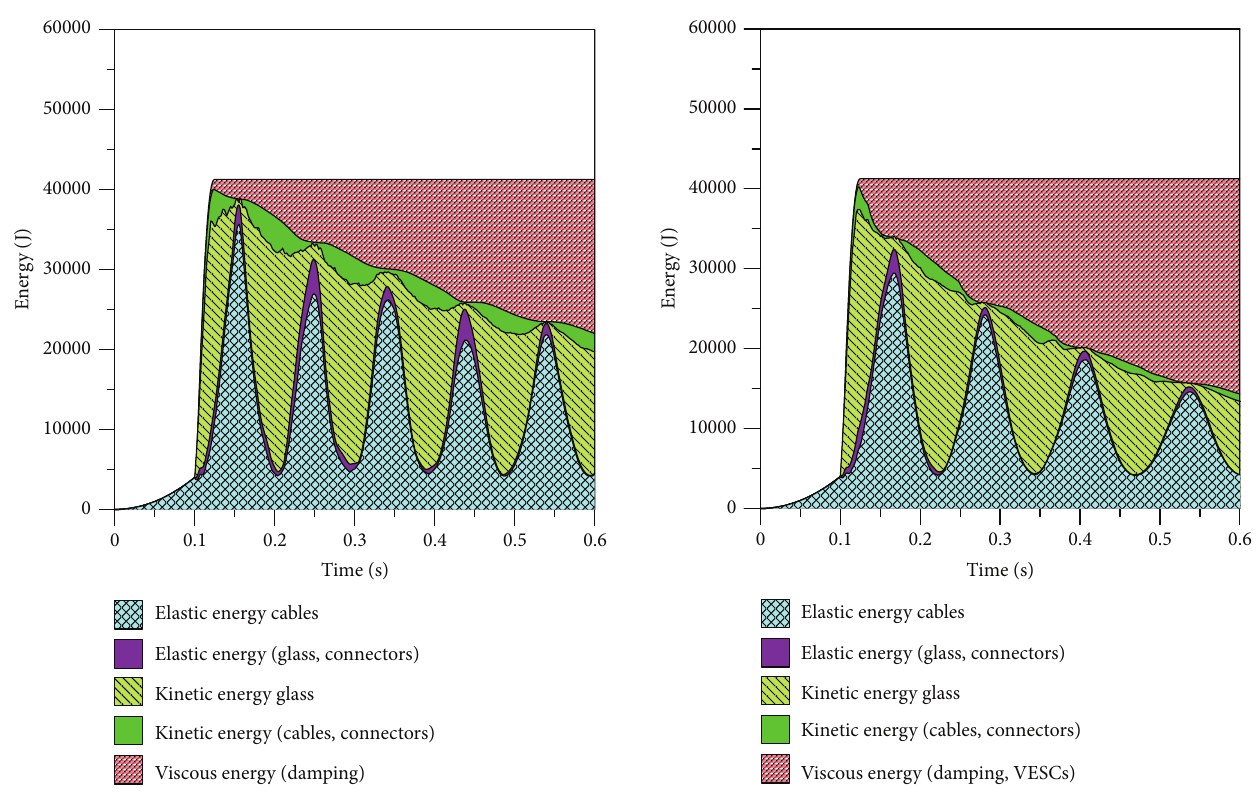
Figure 13: Energy terms for the fac¸ade-module equipped by VESCs